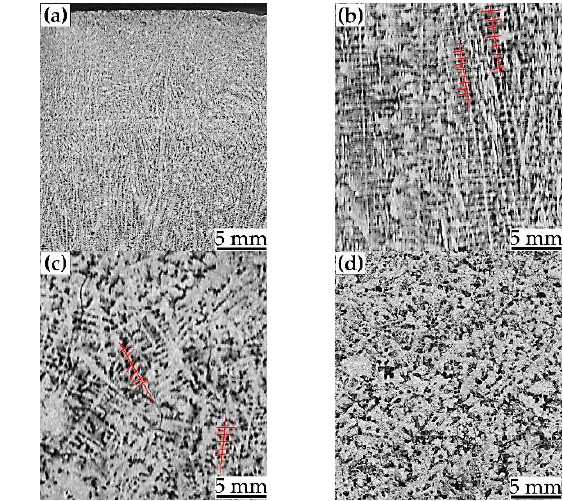
Figure 2. Macrostructure of the partial slab transverse section of medium carbon structural steel 45#. ( a ) Chill zone, ( b ) columnar zone, ( c ) mixed zone and ( d ) equiaxed zone.